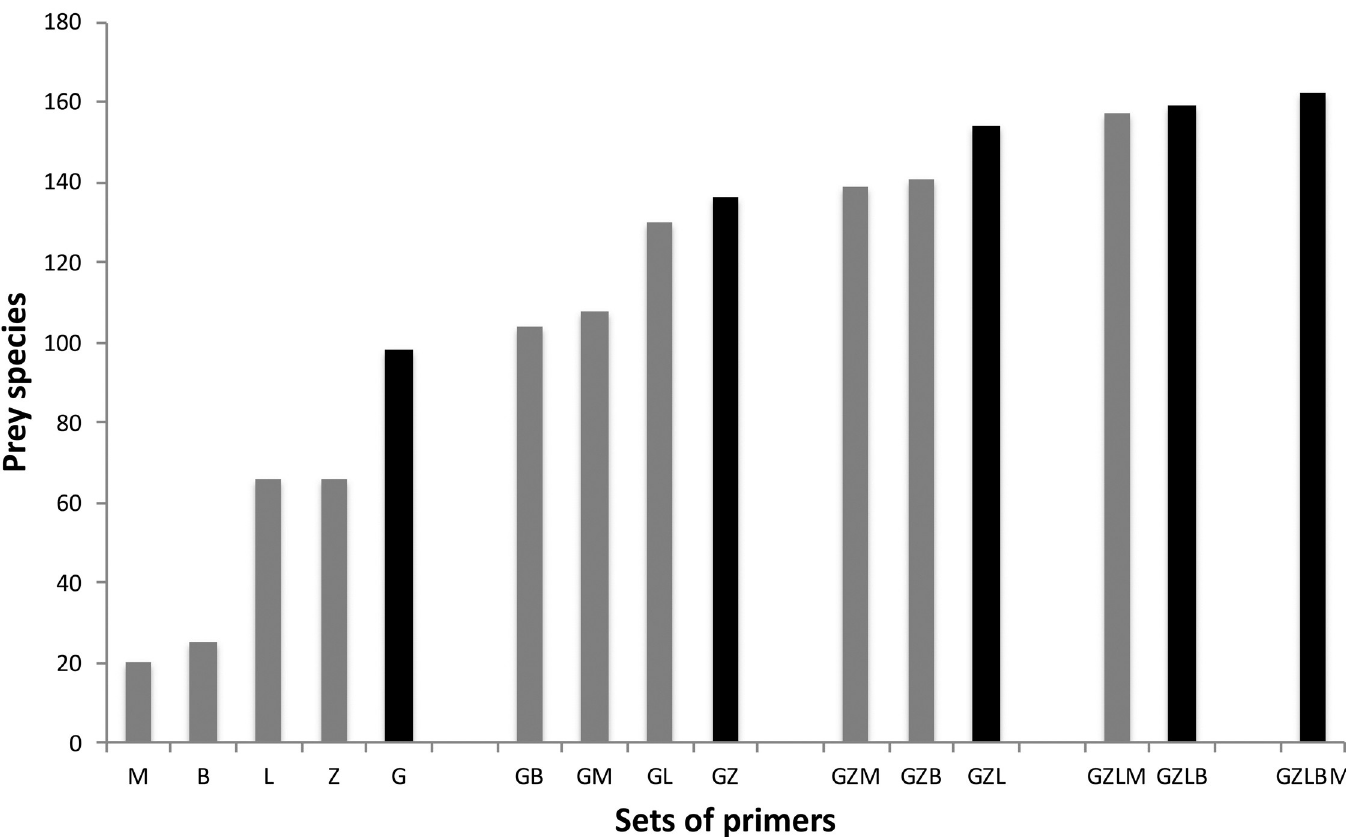
Fig 7. Number of prey species accumulations obtained by different and progressive primer combinations. Progressive primer combinations (one+one, two+one, and so on) were selected according to the highest species accumulation values (black columns) obtained in previous combination-level. B refers to Brandon-Mong primers, G to Gillet, L to Leray, M to Meusnier and Z to